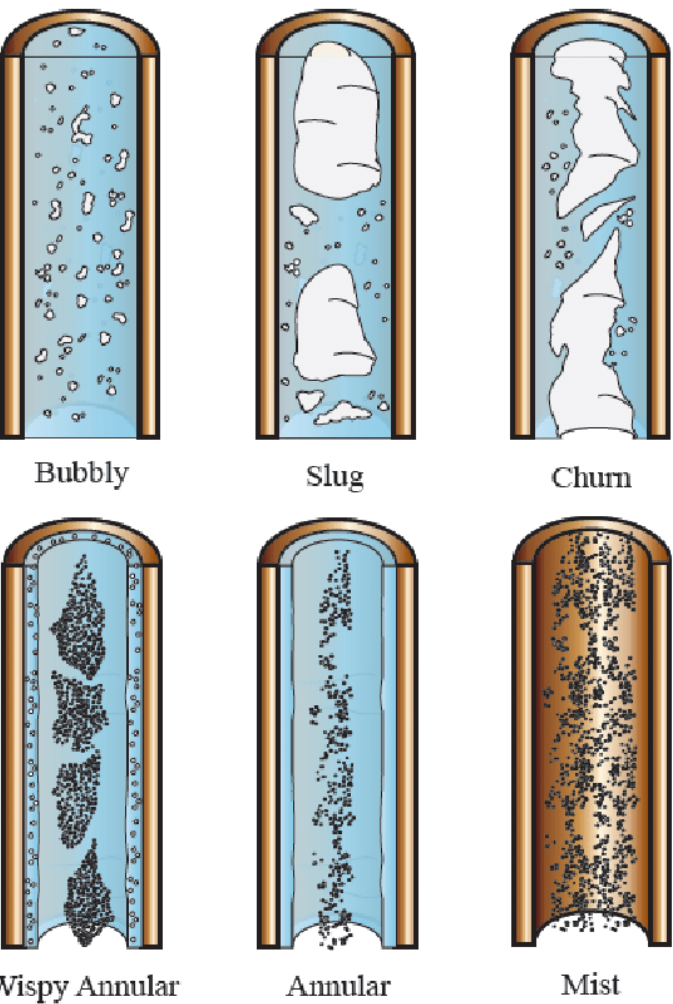
Figure 3. Flow pattern in vertical upward flow.